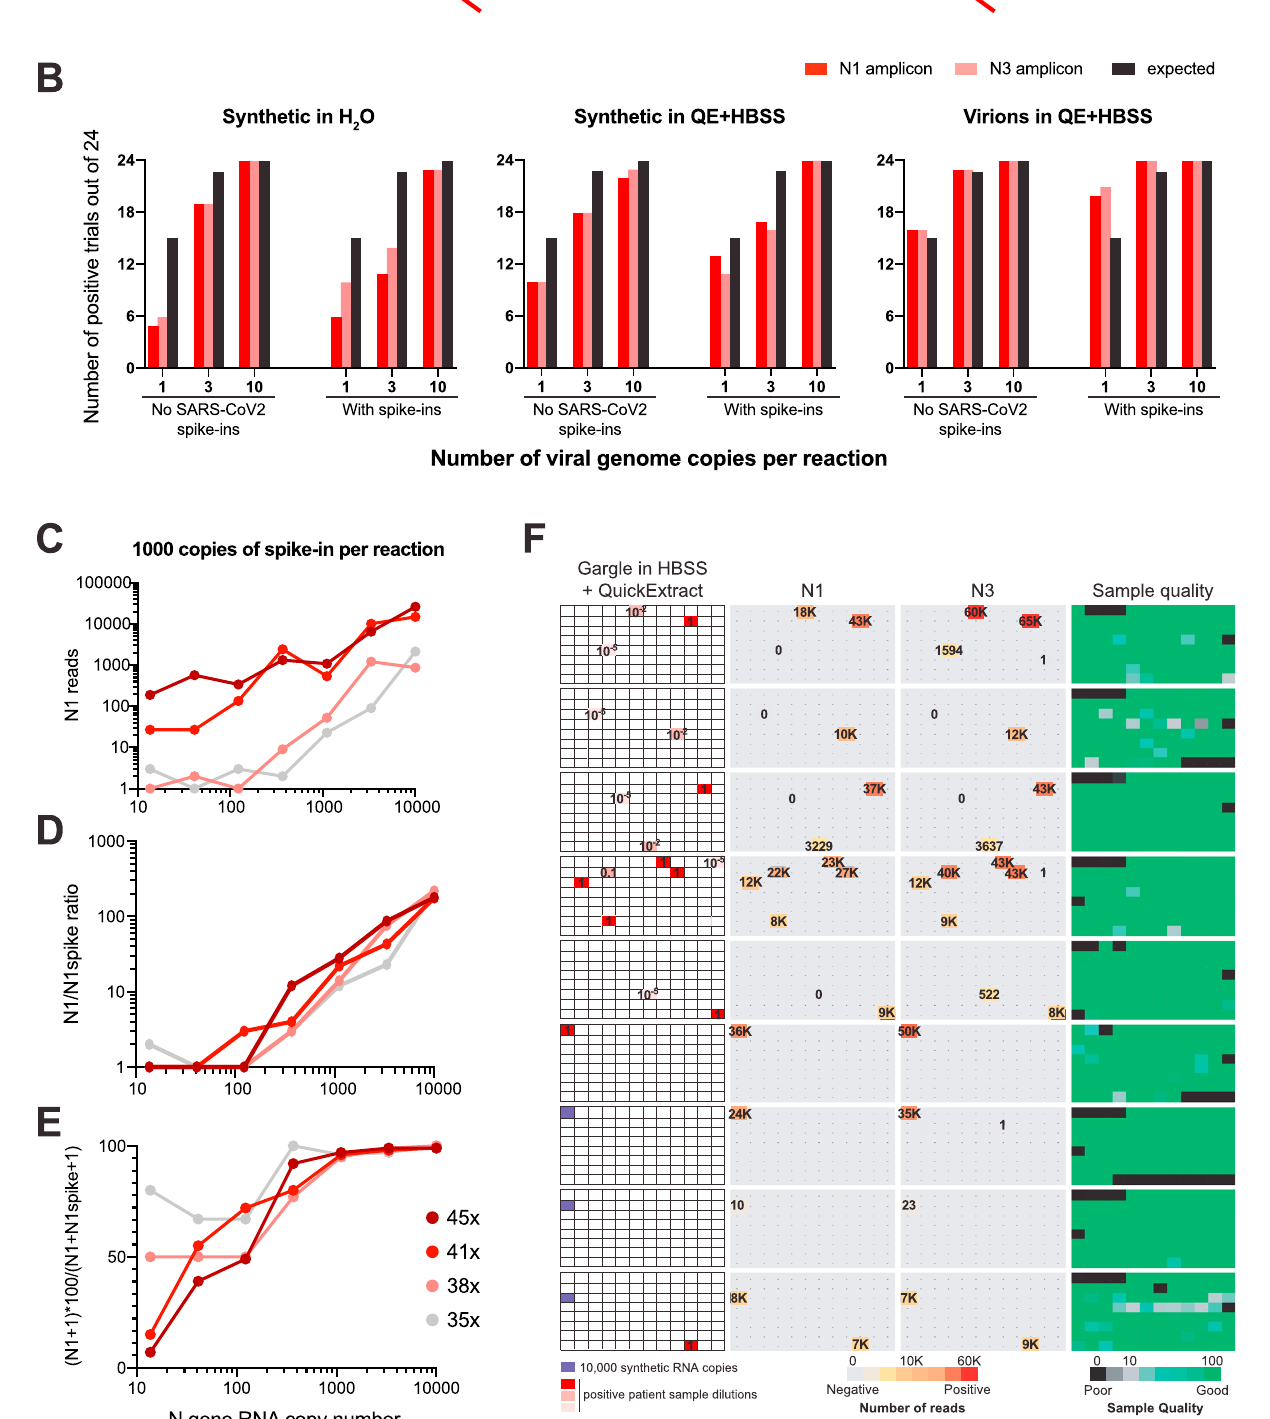
unambiguous assessment of infection status by SARSeq. Due to the absence of false-positive reads we also did not need to further use the N1 and N3 spike-in "denominator" amplicons to set a threshold ratio for calling positive results 22 . In summary, SARSeq enables the semiquantitative assessment of synthetic SARS-CoV- 2 RNA in various buffers and in gargle samples and allows the